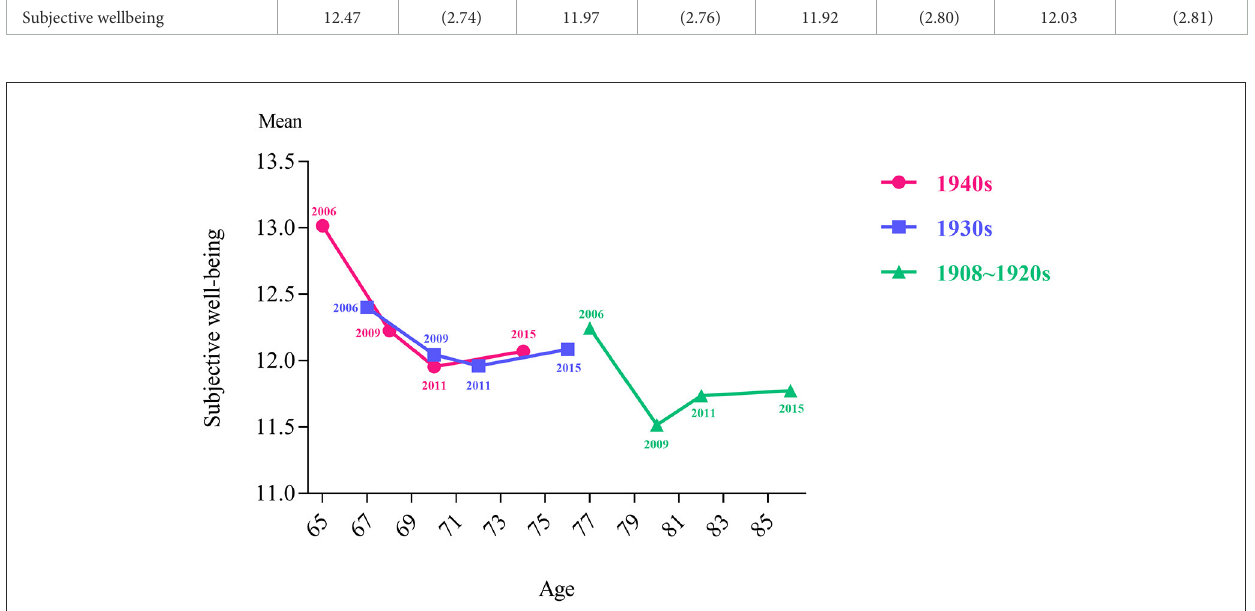
FIGURE3 Subjective wellbeing level of Chinese rural elderly people in different birth generations during 2006–2015.